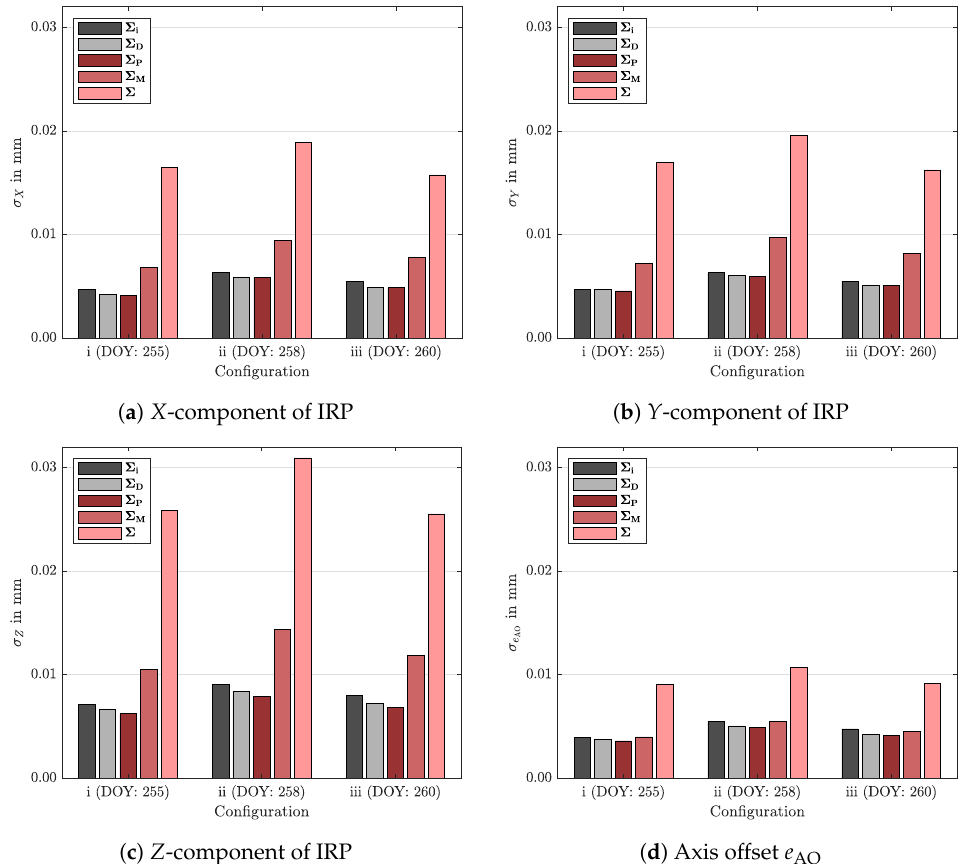
Figure 8. Comparison of the resulting standard deviations of the coordinate components X , Y , Z of the reference point and the axis offset e AO derived by three different measurement configurations, denoted by i, ii, and iii, as well as five different stochastic models. The stochastic model defined by the identity matrix, the diagonal matrix, and the block-diagonal matrix is denoted by Σ I (dark grey), Σ Σ Σ Σ (light red) indicates the stochastic model D (light grey), P (dark red), and M (red), respectively. introducing the fully populated